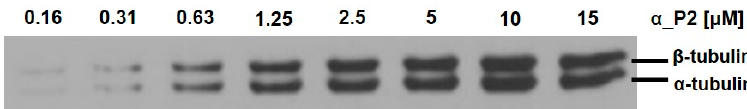
Figure 5. The relative activity of microtubule polymerization of ( A ) P. capsici and ( B ) H. sapiens as a function of increased concentration of inhibitory peptides. The activity for P. capsici yielded the following values of IC 50 ; α _P1 ( ■ ), 2.69 µM; α _P2 ( ● ), 802 nM; α _P3 ( ▲ ), 1.24 µM; β _P1 ( ▼ ), 6.91 µM.